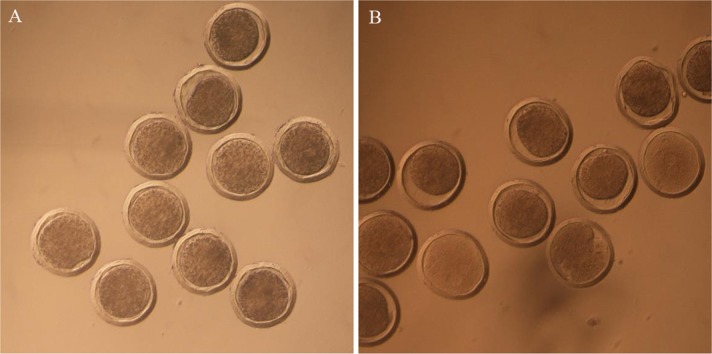
Pictures of embryos before and after vitrification.(A) Microinjected embryos before vitrification; (B) microinjected embryos after thawing.